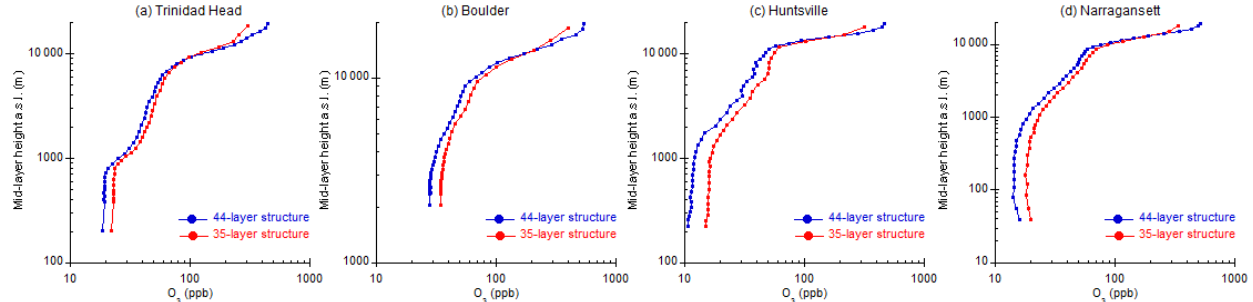
Figure 3. Impact of layer configuration on simulated mean O 3 vertical profiles for August 2006 at selected locations for a case involving zero-out of emissions across the United States: (a) Trinidad Head, CA; (b) Boulder, CO; (c) Huntsville, AL; and (d) Narragansett,